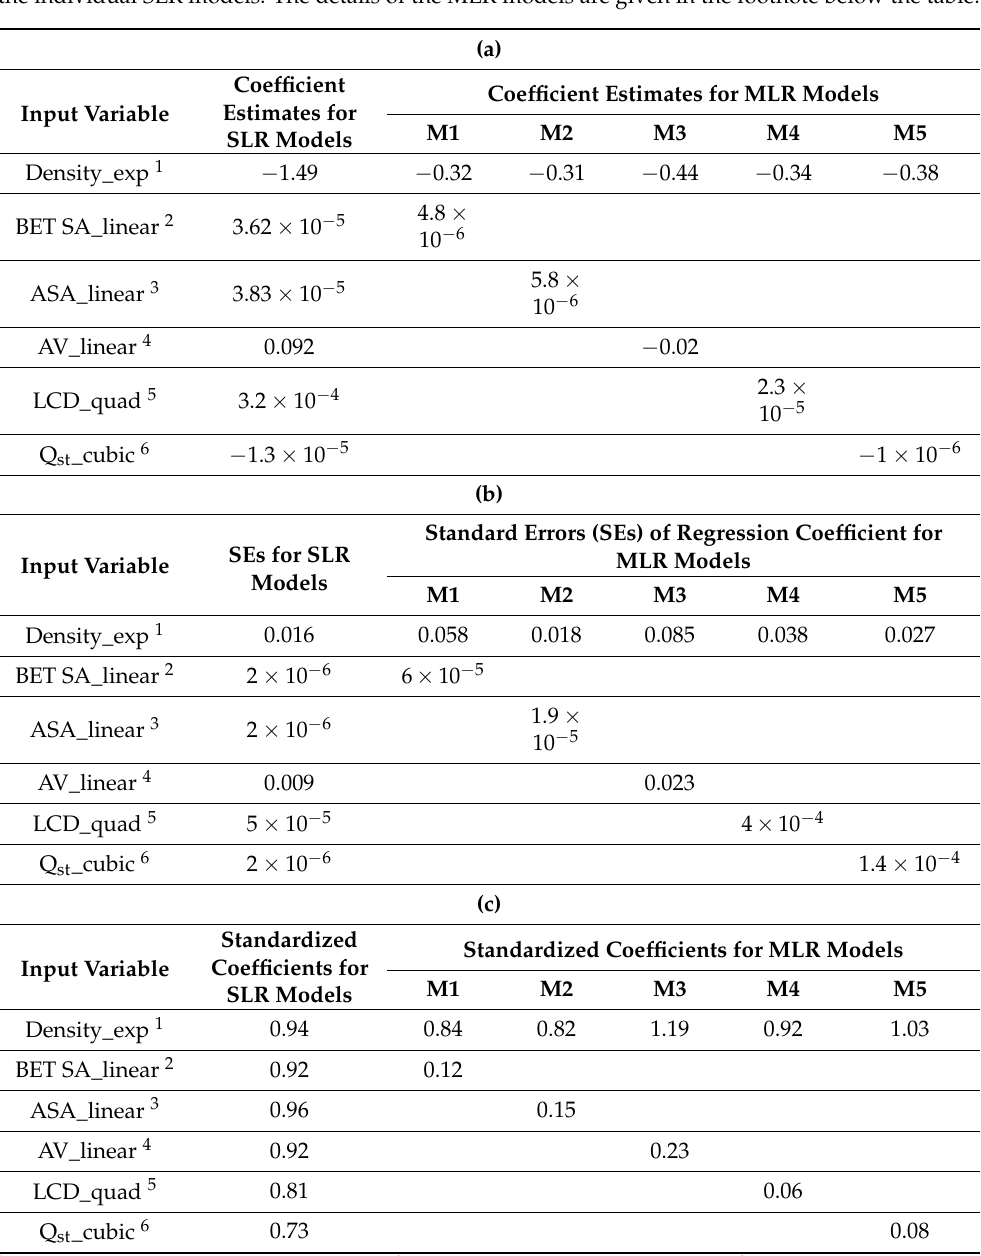
Table 6. ( a ) Comparison of the regression coefficient estimates for the two-input MLR models, with density as one of the inputs and the individual SLR models. The details of the MLR models are given in the footnote below the table. ( b ) Comparison of the standard errors (SE) of the regression coefficient estimates for the two-input MLR models, with density as one of the inputs and the individual SLR models. The details of the MLR models are given in the footnote below the table. ( c ) Comparison of the standardized coefficients for the two-input MLR models, with density as one of the inputs and the individual SLR models. The details of the MLR models are given in the footnote below the